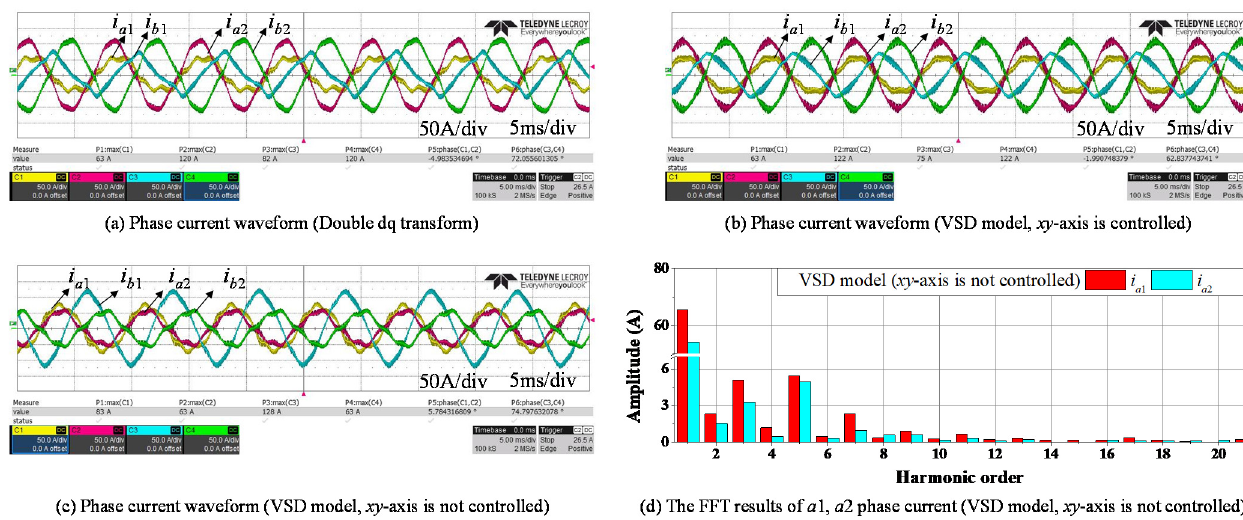
Figure 12. ( a – d ) Experiment results of phase current waveform according to the coordinate transformation methods in a single-phase open fault.